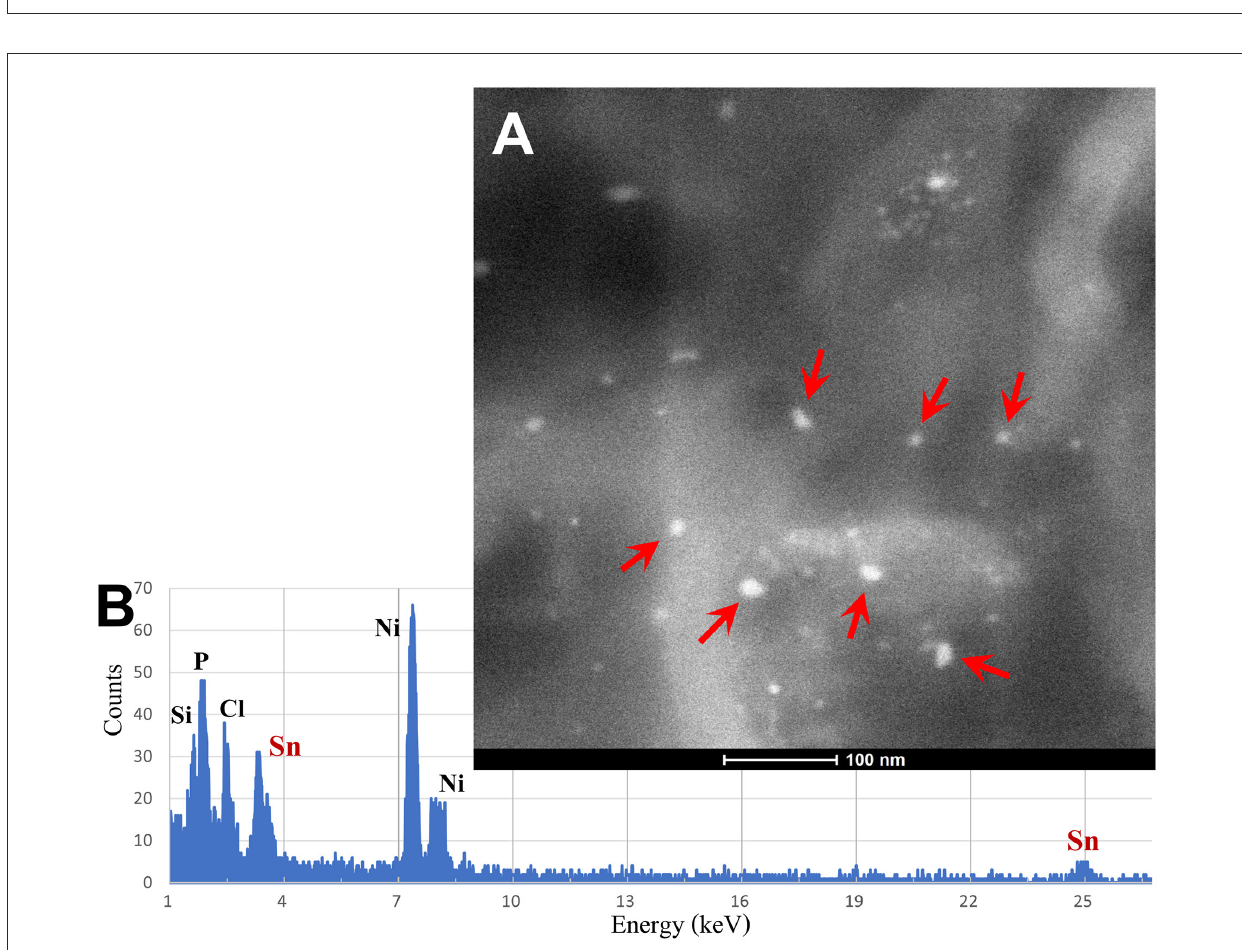
FIGURE8 (A) Using the transmission electron microscopy (TEM) Z-contrast technique, metallic nanoparticles are documented in brain tissues. Only the nanoparticles marked with red arrows are Sn-NPs, while the rest are Fe-NPs. (B) The presence of Sn-NPs is verified through the acquired energy-dispersive X-ray spectrometry (EDX) that shows the tin metal (Sn) peak.